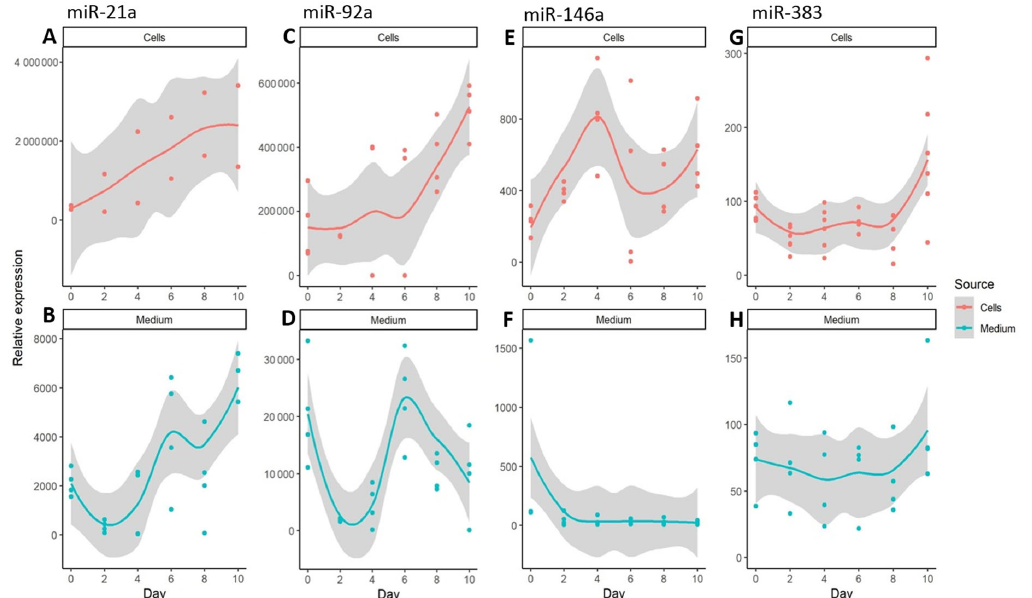
Figure 4. Relative expression levels of extracellular and intracellular miRNAs related to inflammation during the ten days of adipocyte differentiation. The expression of miR ‐ 21a ( A , B ), miR ‐ 92a ( C , D ), miR ‐ 146a ( E , F ), and miR ‐ 383 ( G , H ) was normalized using RNU6B. Dots represent the actual measurements, the line is a local regression based on the collected data points, and the gray area represents the 0.95 confidence interval for the regression line.